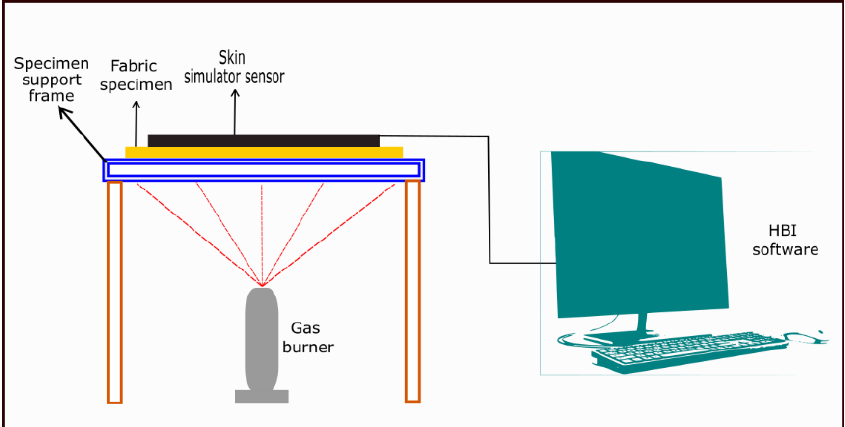
Figure 1. Thermal protective performance evaluating tester under flame exposure.